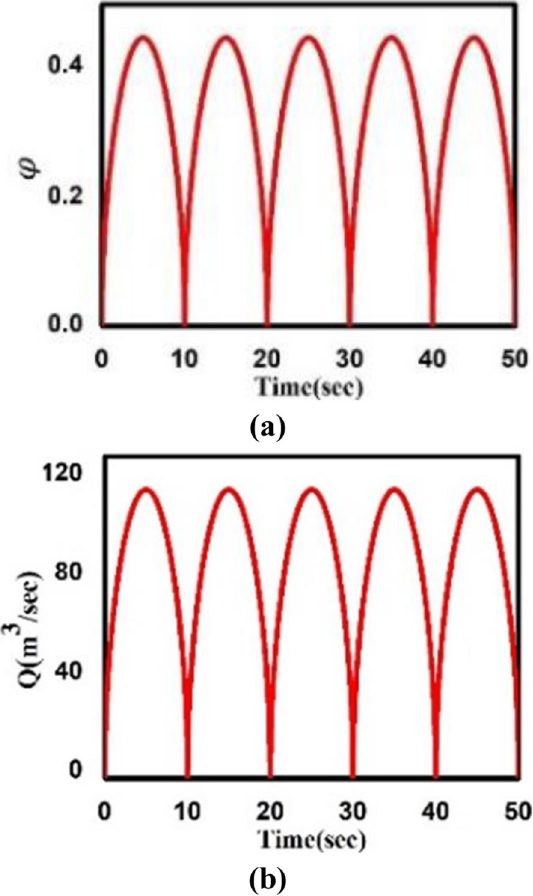
Fig. 10 Attributes of the modelled OWC chamber. a) Flow coefficient. b) Flow